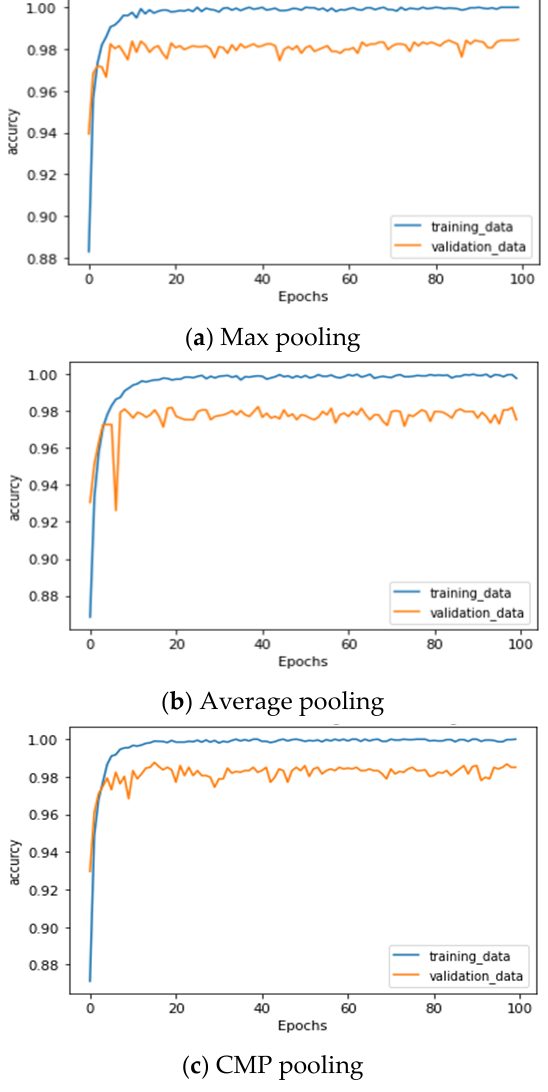
Figure 7. Pooling performance comparison using Caltech 101 data.